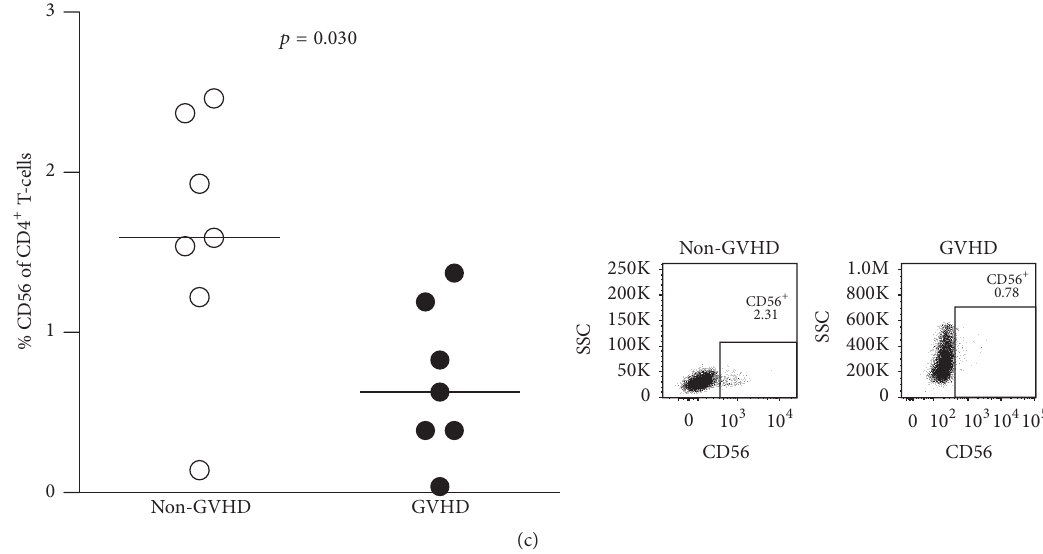
Figure 2: The non-GVHD group had higher frequencies of CD94 + , TCR 𝛾𝛿 + , CD56 + , and CD95 + T-cell subsets than the GVHD group in unmanipulated donor samples. Each dot represents the cell-subset frequency of one donor and horizontal bars indicate the median of each group. Representative FACS plots are shown below each dot-plot of one non-GVHD and one GHVD patient. Statistical analysis was done with the Mann–Whitney 𝑈 test. (a) Percentages of CD94 + , TCR 𝛾𝛿 + , and CD95 + na¨ıve T-cells were increased within the non-GVHD